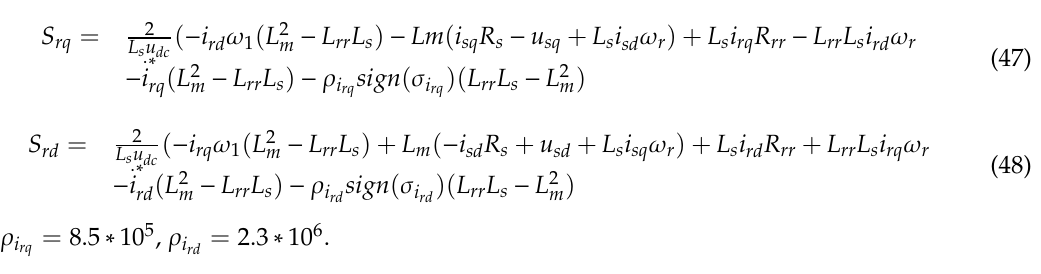
Figure 5. Conventional first ‐ order sliding mode control (SMC) scheme.